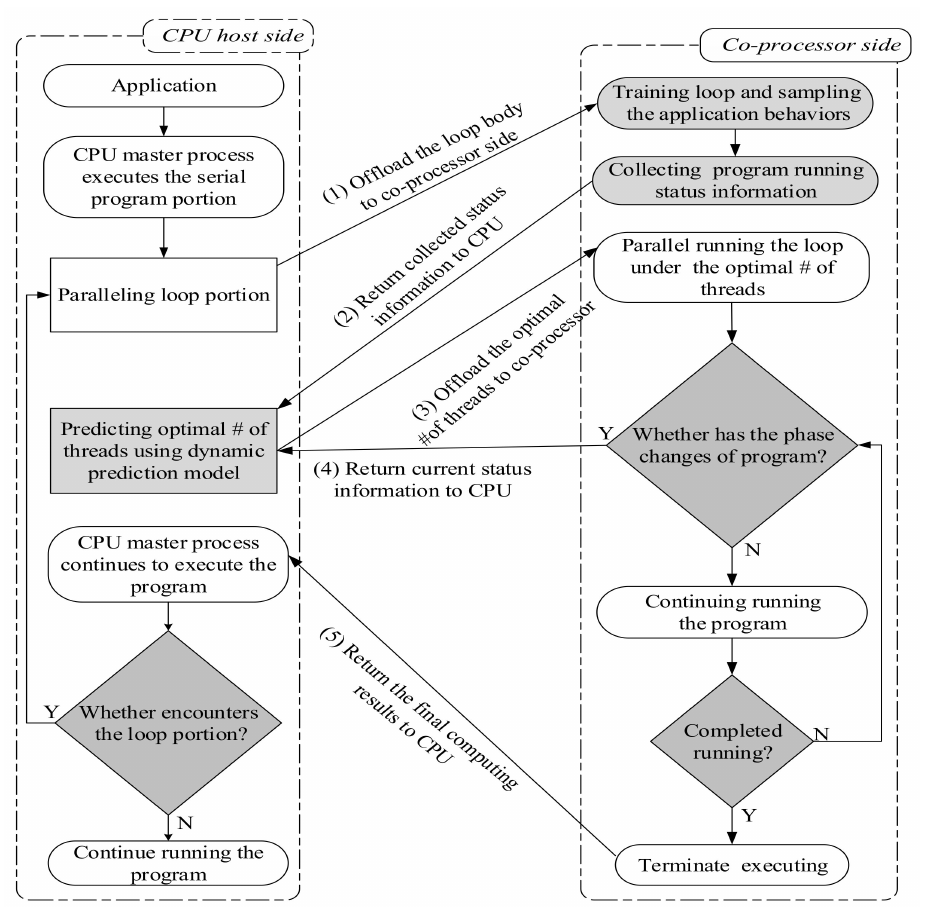
Figure 3. DPTM framework on the MIC heterogeneous